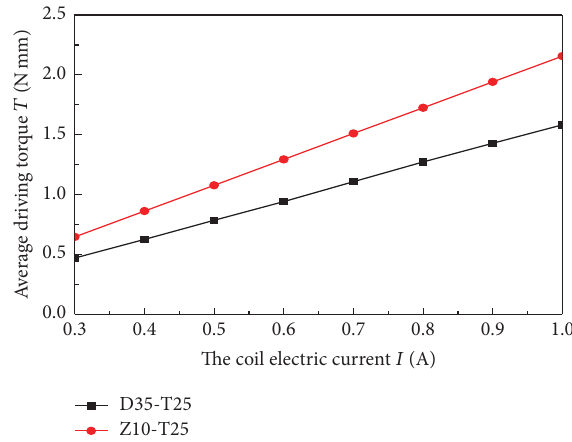
Figure 8: Comparison of driving torque simulation envelope of three kinds of electromagnet.